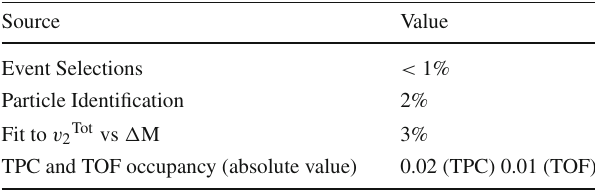
Table 2 Summary of the systematicuncertainties for the determination of the deuterons v 2 coefficient